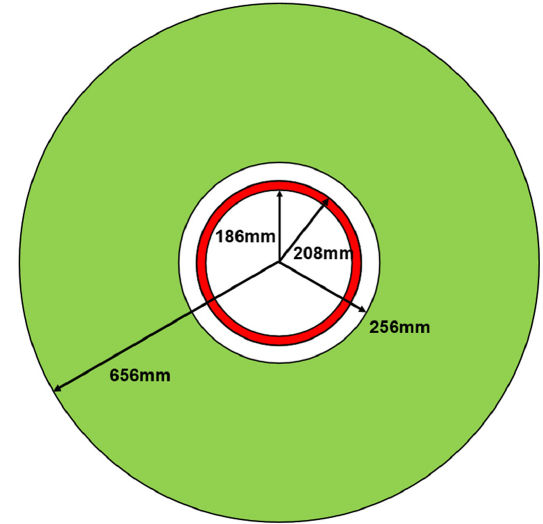
FIG. 5. Cross-sectional view of the superconducting 90° combined-function magnet. Red: coil; green: shielding